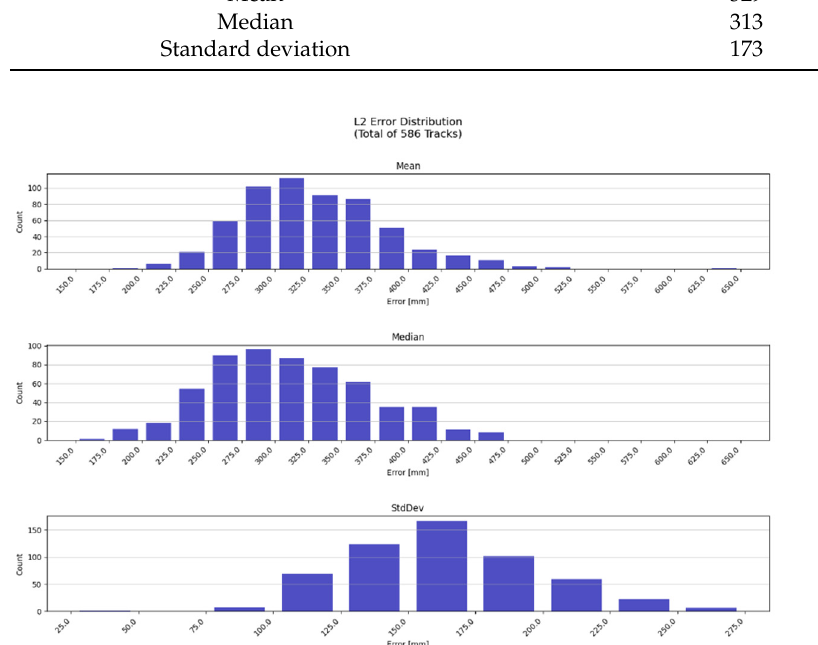
Figure 14. L2-error distribution for predicted tracks in test runs in 3D Video. Figure 14. L2 ‐ error distribution for predicted tracks in test runs in 3D Video.